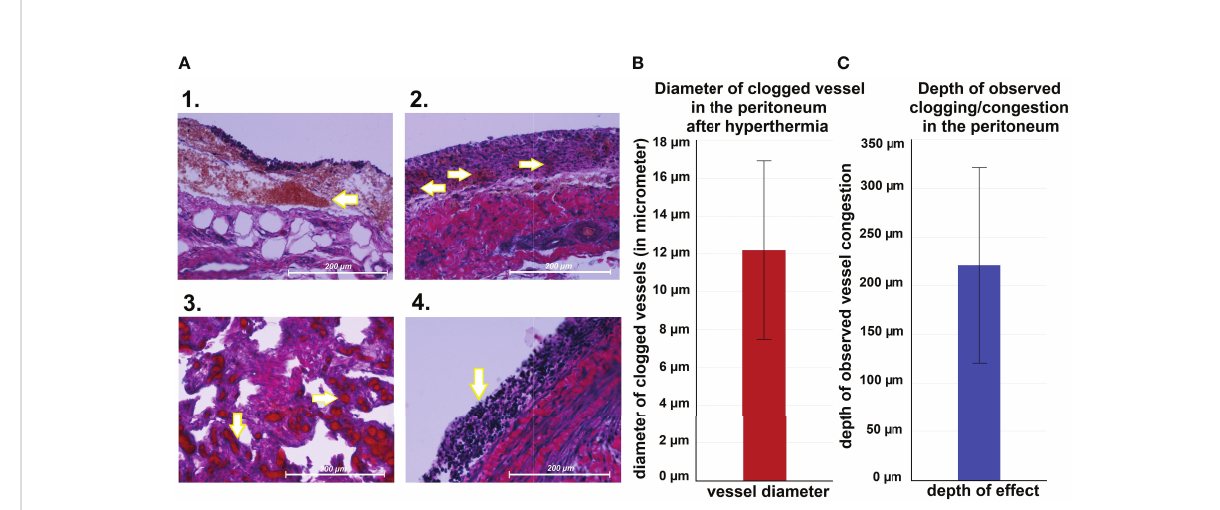
FIGURE 4 (A) Microscopic peritoneal changes following high- fl ow gas-based hyperthermia. 1. small „ hyperthermic ” petechia, 2. Micropetechia on the peritoneal surface. 3. Clotting of capillary vessels on the peritoneal surface. 4. Peritoneal white blood cell in fi ltration. (B) Measured diameter of clotted vessels on the peritoneal surface. (C) Depth land extent of vessel